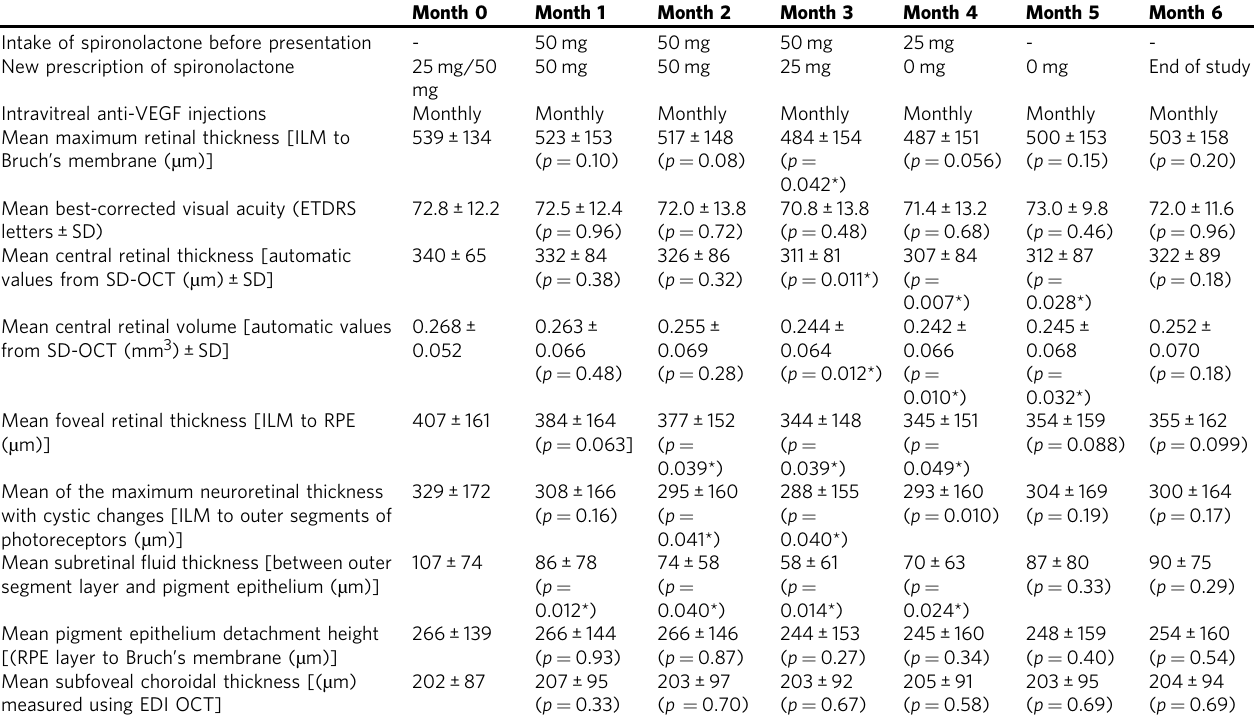
Table 1 Functional and structural outcome measures in nAMD patients treated with